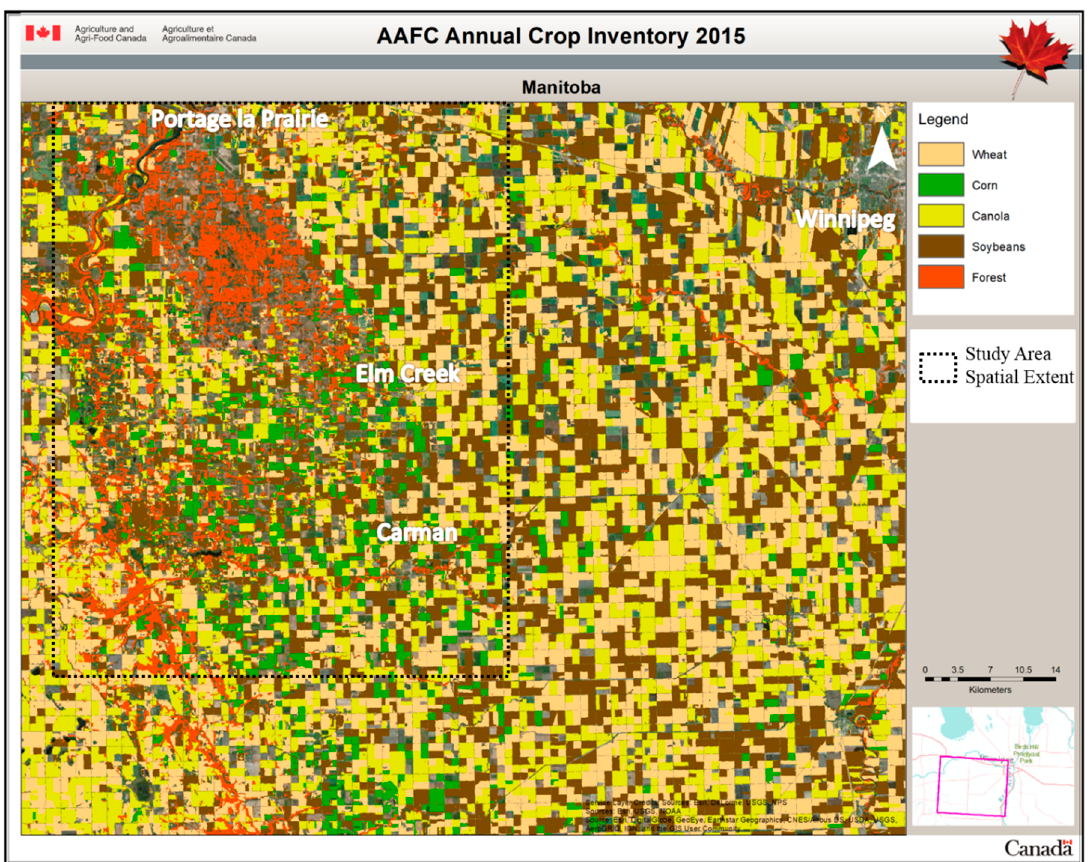
Figure 2. A map of the land uses in 2015 for the experimental site created by Agriculture and Agri-Food Canada (AAFC).